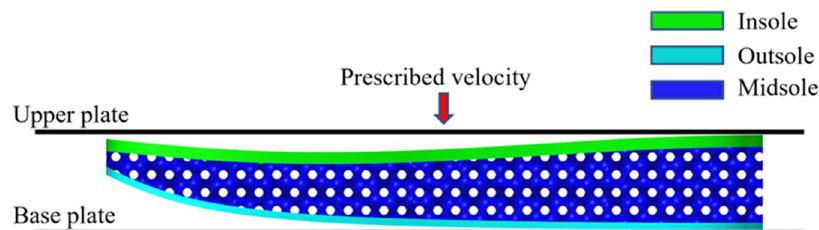
Figure 5. FE model of the sole with Gyroid configuration under quasi-static compression.